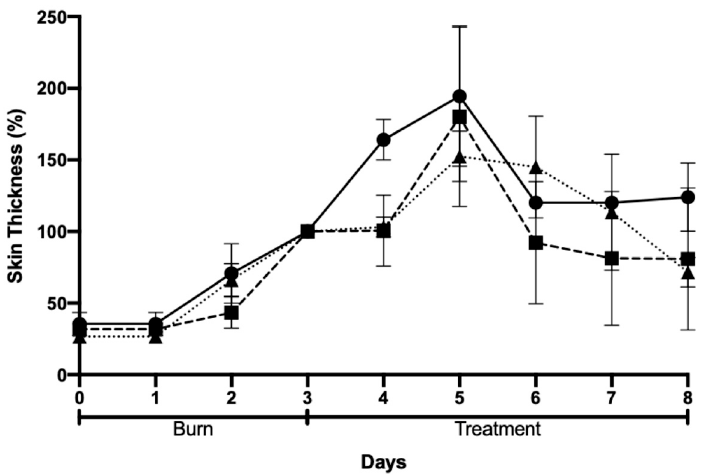
Figure 10. Skin thickness after chemically induced burn and treatment: negative control (Pluronic ®